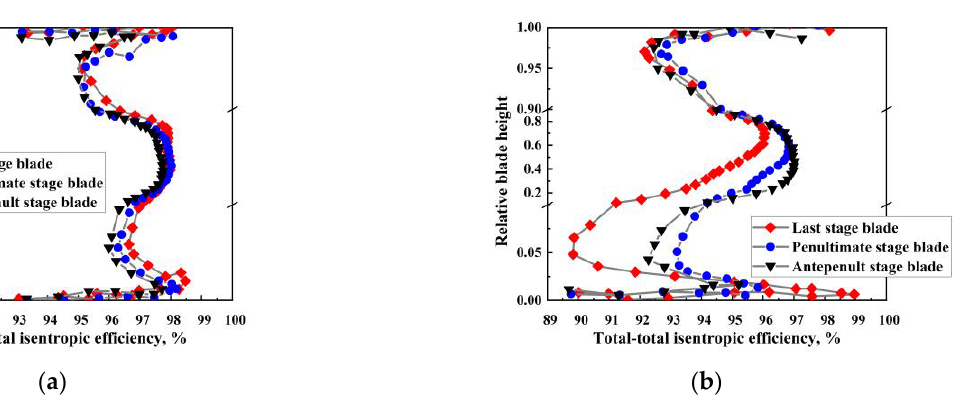
Figure 11. Distribution of the total-total isentropic efficiency along the blade height (3.4 MPa back pressure): ( a ) 100% load ratio; ( b ) 50% load ratio.